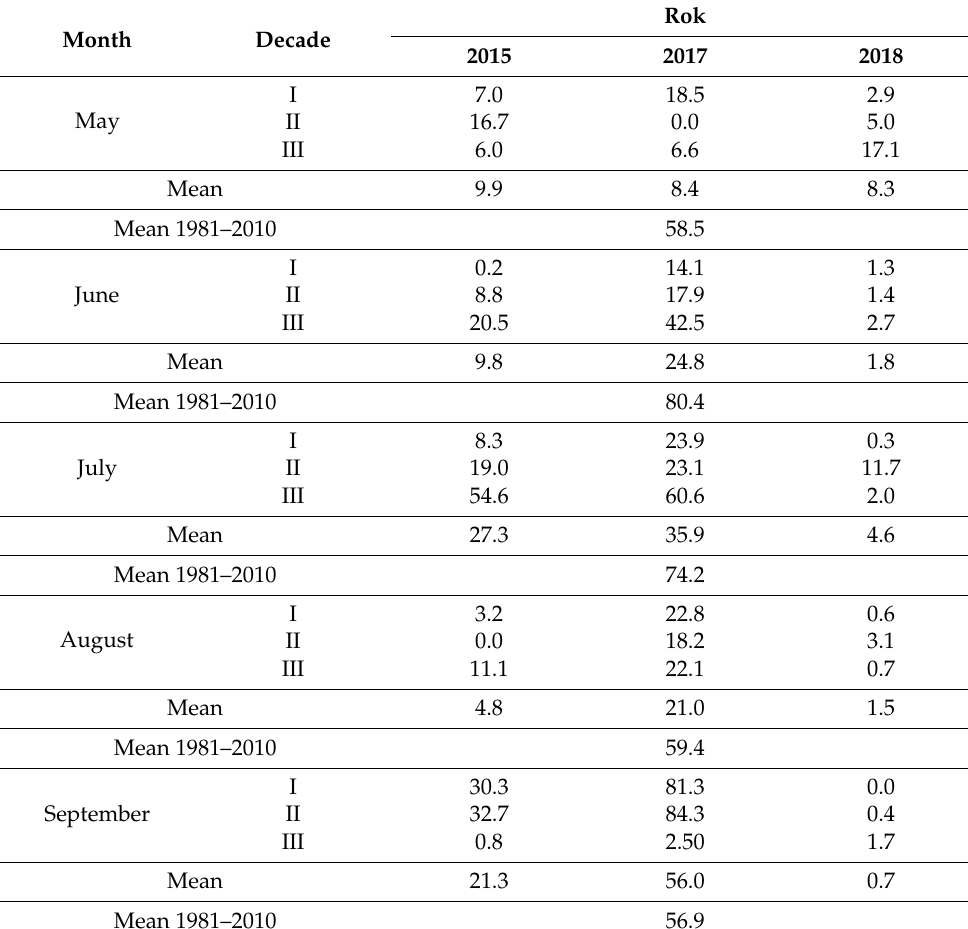
Table 5. Total ten-day and monthly precipitation during the study according to the Hydrological and Meteorological Station in Tomaszkowo